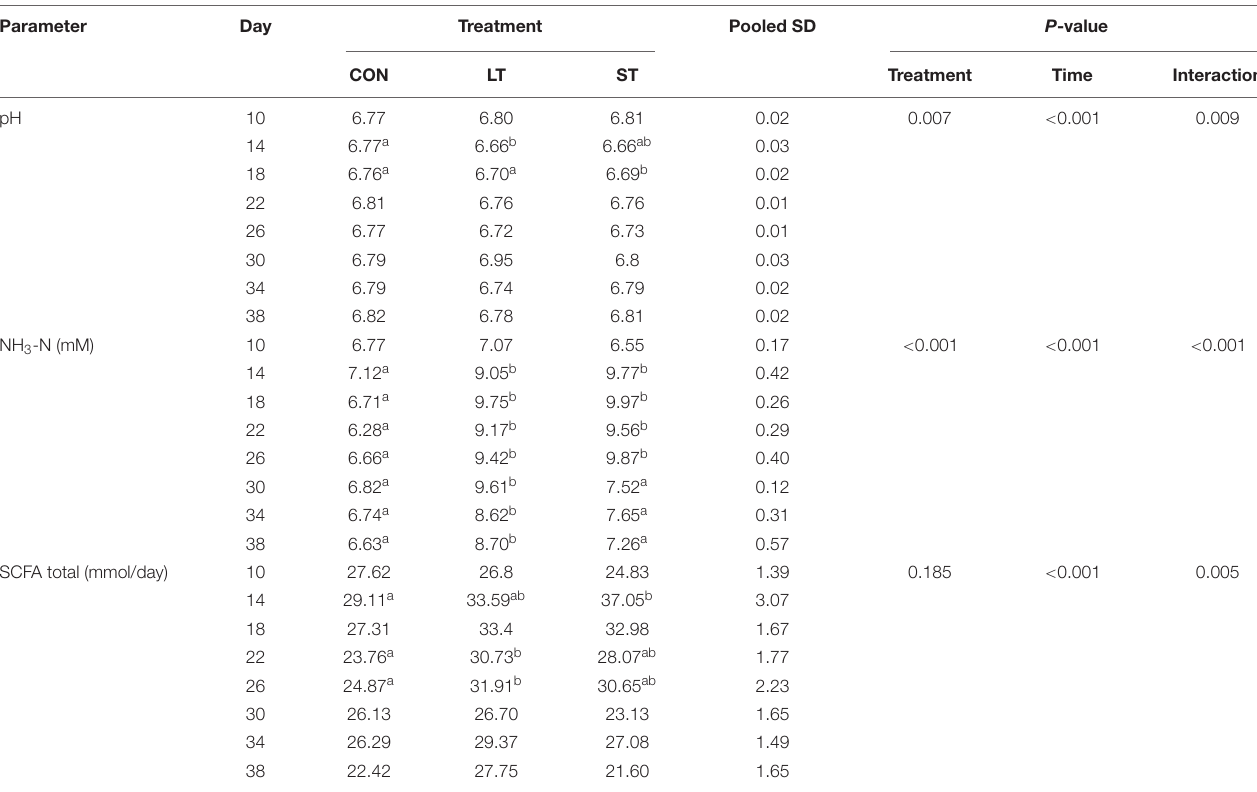
TABLE 1 | Fermentation parameters at day 10 (baseline period) and every fourth day of experimental period (days 14–38). Parameter